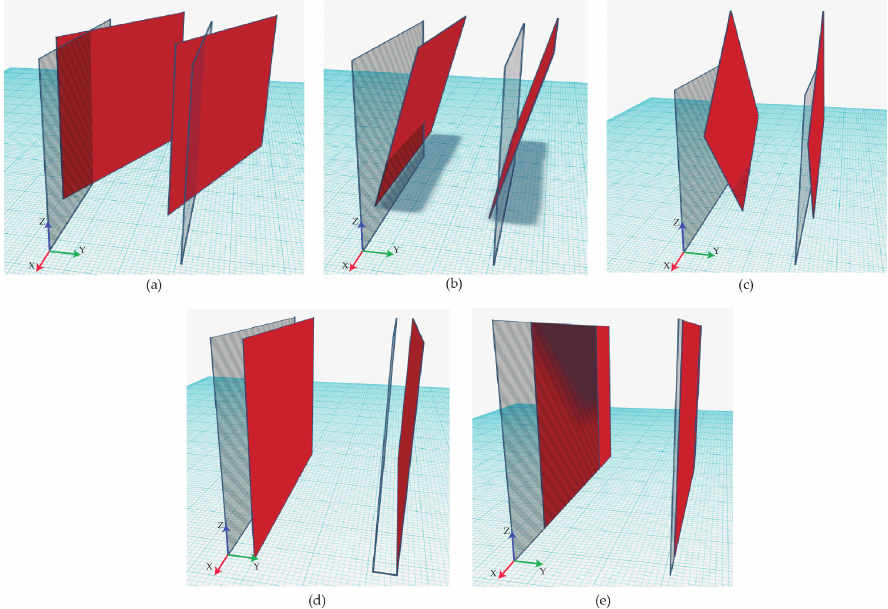
Figure 14. Visual representation of aligning errors between virtual planes (transparent) of the virtual 3D model and scanned planes (red) of the real world: ( a ) Z-axis rotation, ( b ) Y-axis rotation, ( c ) X-axis rotation, ( d ) Y-axis translation and ( e ) X-axis